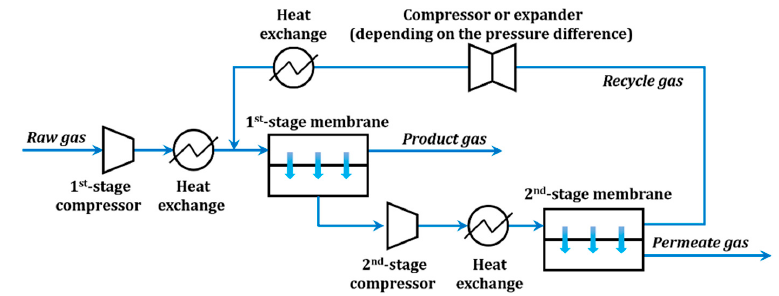
Figure 11. Schematic diagram of a two-stage membrane process.